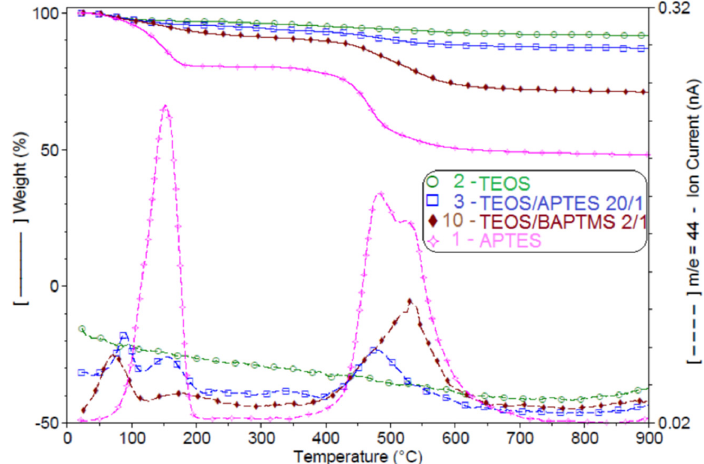
Figure 7. CO 2 weight loss (TG ‐ MS diagrams) recorded for representative aminosilica supports.